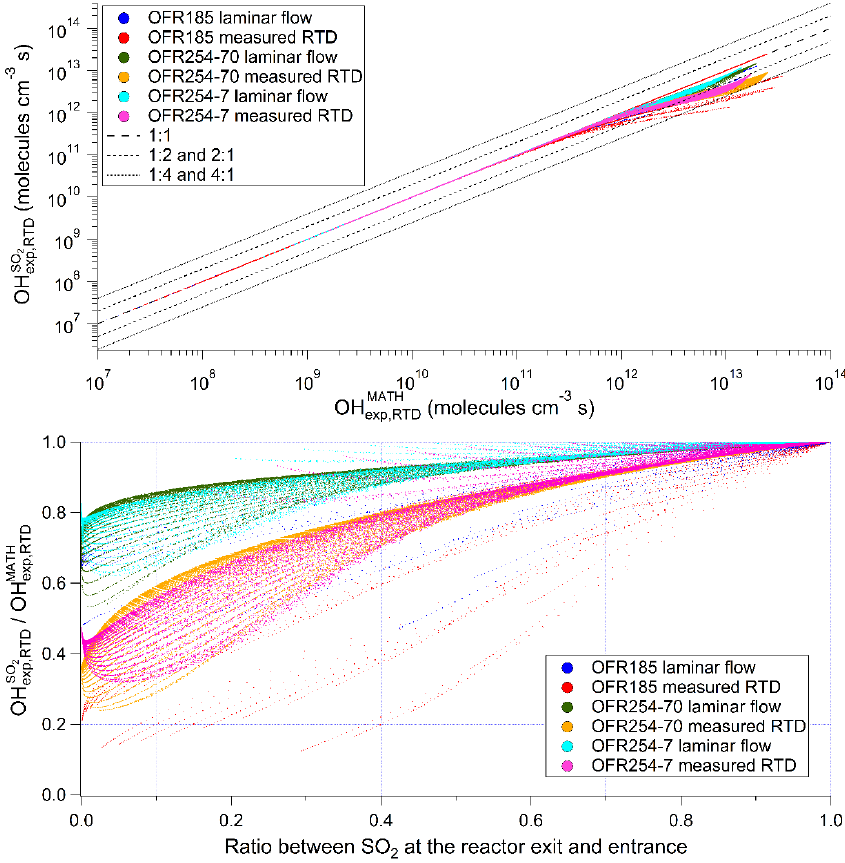
Figure 10. (upper) OH exposures estimated from SO 2 decay in the models with residence time distributions (OH SO 2 from direct integration for the models with residence time distributions (OH MATH for comparison. (lower) Ratios between the two types of OH exposures as a function of the fractional consumption of SO 2 in the reactor. For each type of RTD, 2700, 27900, and 27900 datapoints are shown for OFR185, OFR254-70, and OFR254-7,